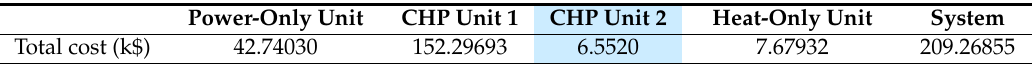
Table 8. The units’ cost for different participation percent in demand response for a typical day in week 15.